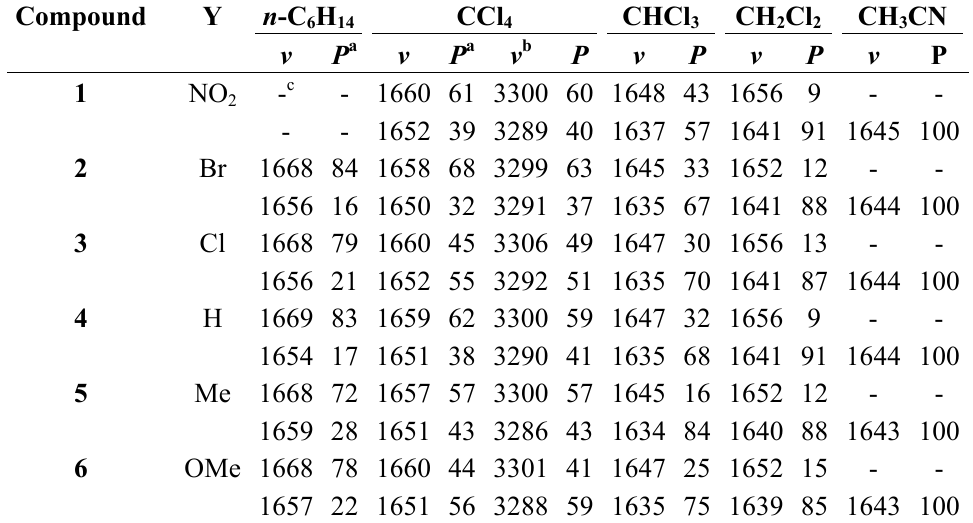
Table 1. Frequencies ( ν , cm − 1 ) and intensities of the carbonyl stretching bands in the IR spectra of 3-(4 ′ -substituted-phenyl)sulfanyl-1-methyl-2-piperidones 1 – 6